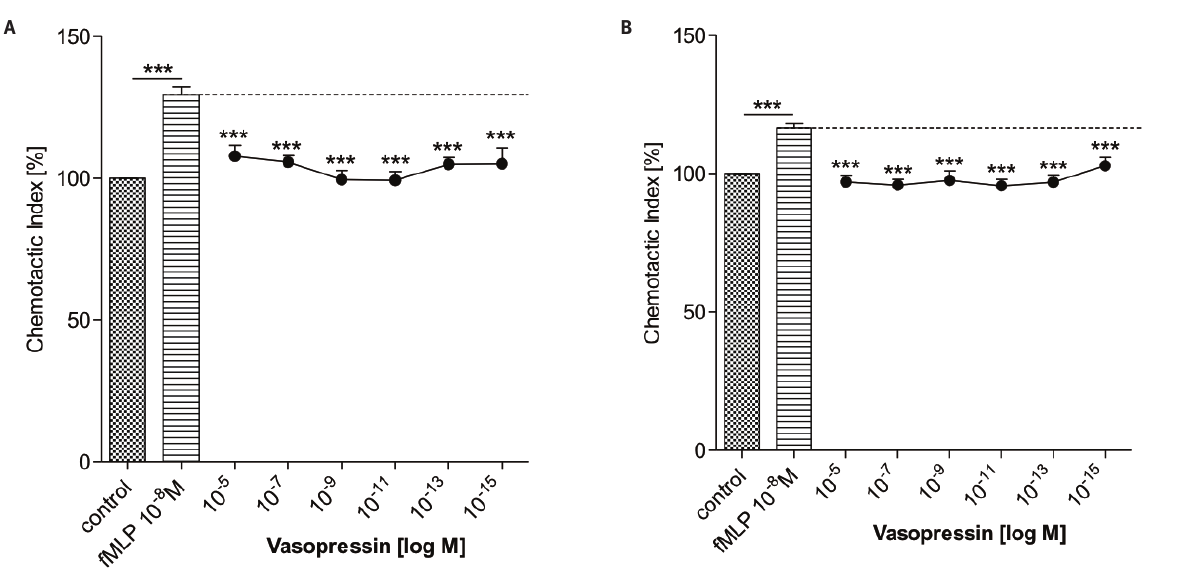
Figure 3: Priming cells with different concentrations of AVP PMNs (A) and monocytes (B) were pre-incubated with different concentrations of AVP for 30 min and migrated against AVP [10-9 M]. Migra- tion towards medium served as the negative control, as positive control, migration against fMLP [10-8 M]. Statistical analyses: Mann-Whit- ney U test [n.s., not significant, *, p<0.05, **, p<0.01, ***, p<0.0001] Table 1: Checkerboard analysis in response to AVP